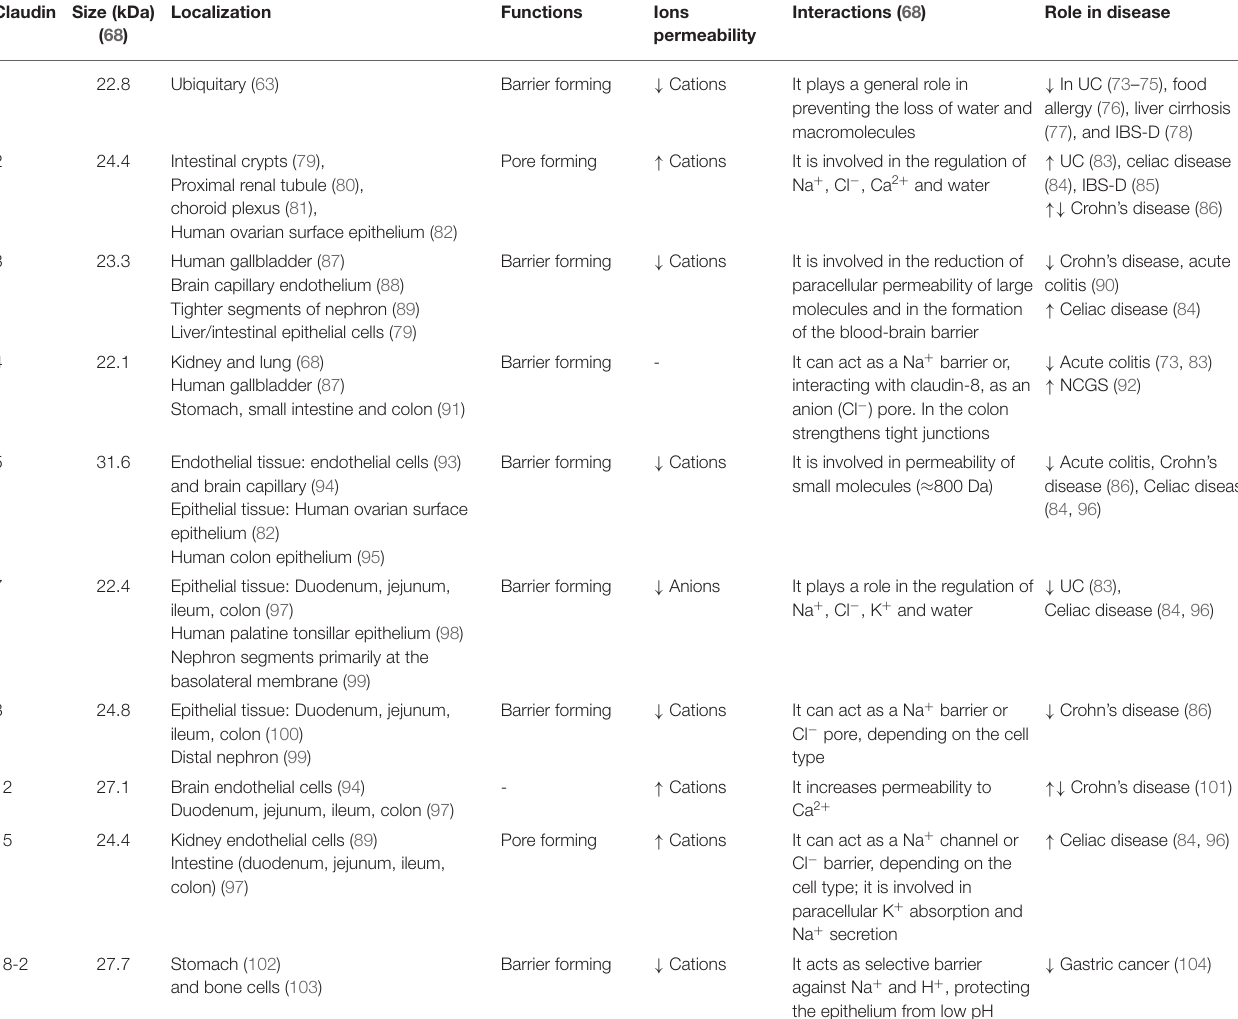
TABLE 1 | Characteristics of claudins and their changes in intestinal diseases. Claudin Size (kDa) (68)